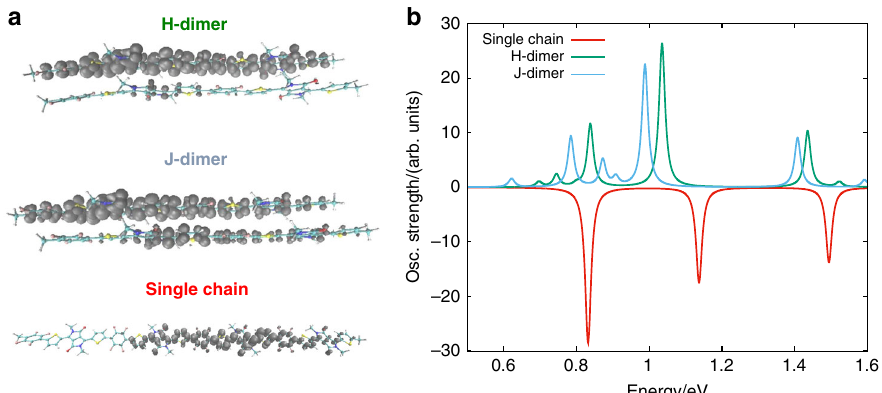
Fig. 9 Spin density distribution. a Computed UDFT ( ω -UB97X-D/6-311 G*) spin density for the charged ( − 1) species of the single chain and H- and J- dimers (both alpha and beta spin densities are highlighted in grey, isosurface values 0.0003 a.u.). b Computed TD-UDFT optical polaron transitions for single chain (red), H- (green) and